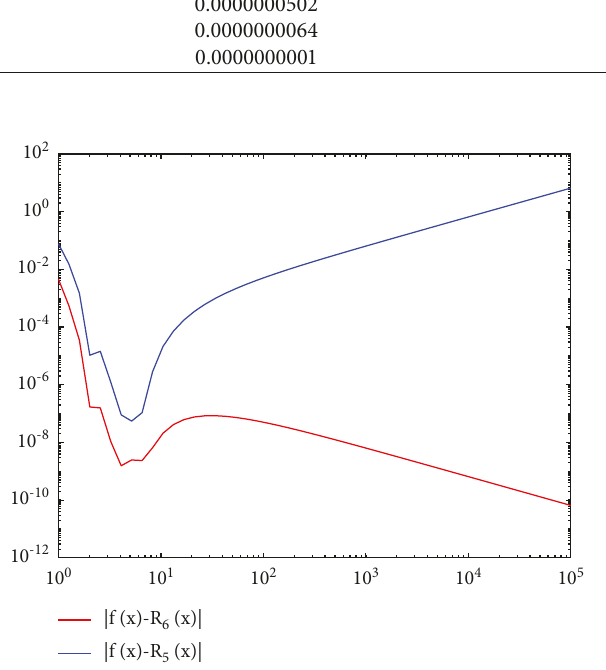
Figure 4: Function plots of | f ( x ) − R